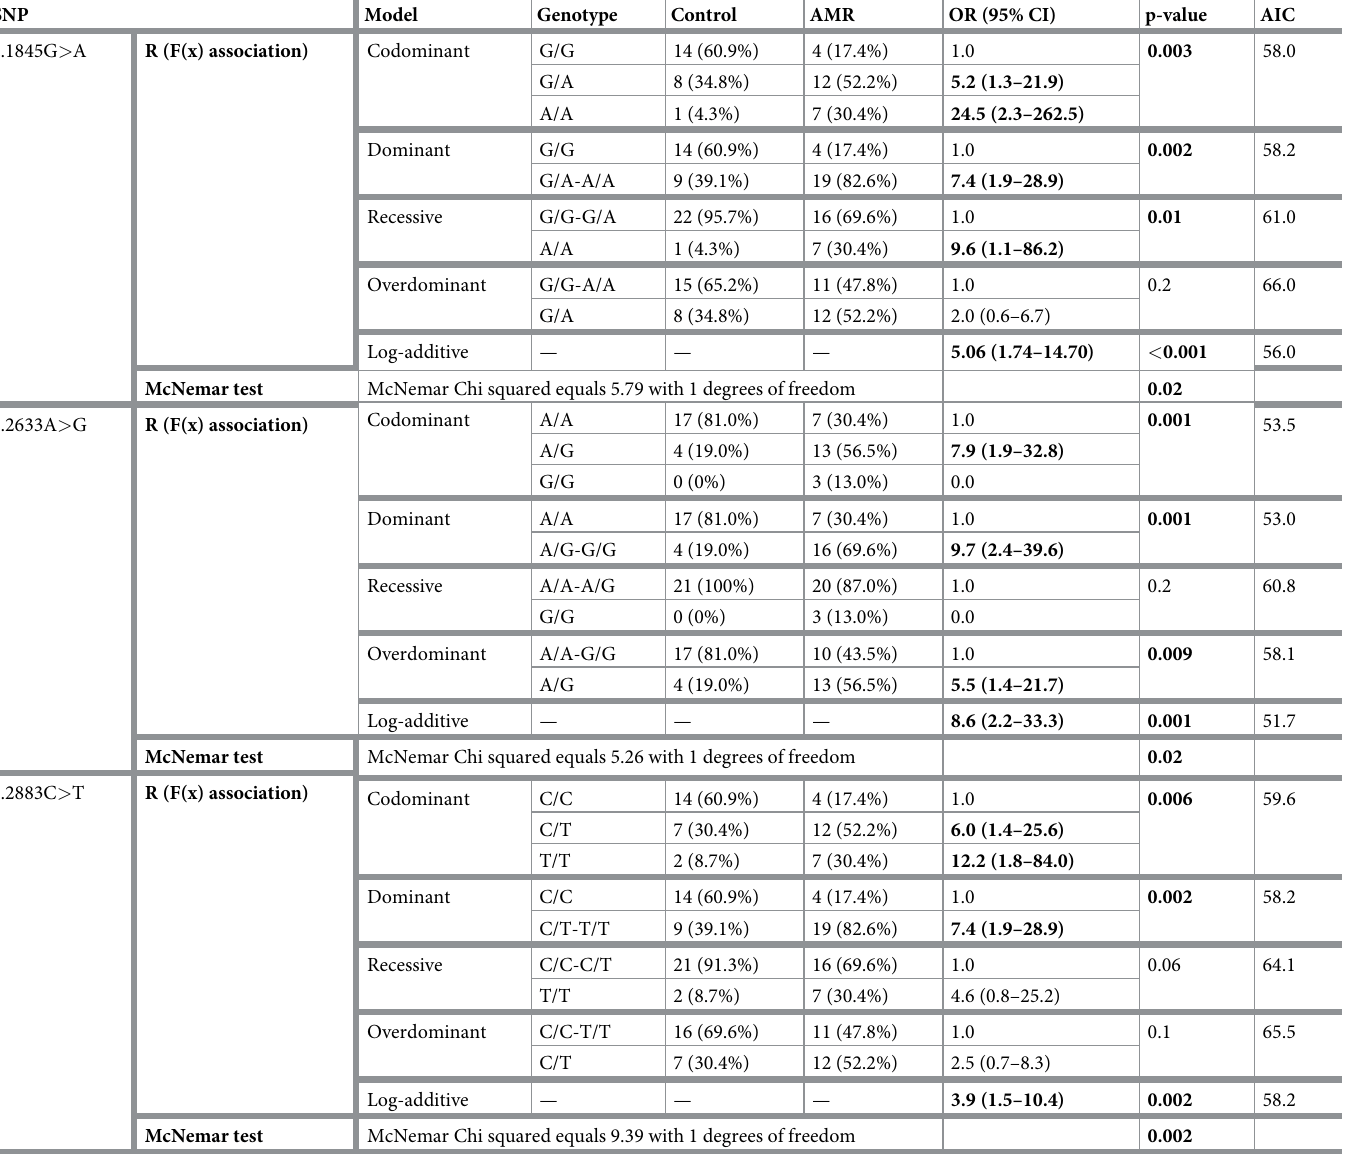
Table 2. Statistical analysis of 3 variants in ITGA4 gene in control and AMR